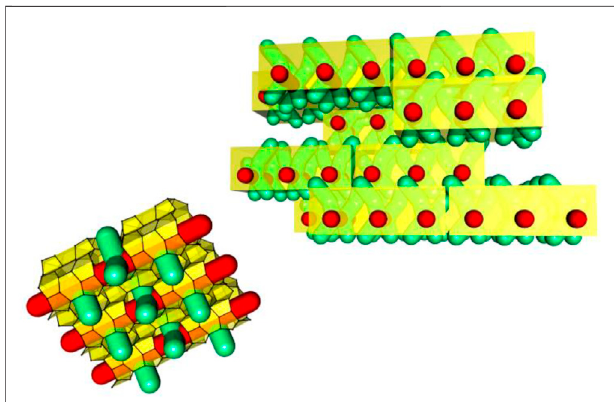
FIGURE 2 | Schematic representation of tiling patternsof nanoslabs in a zeogrid (adapted with permission from Martens et al., 2011).